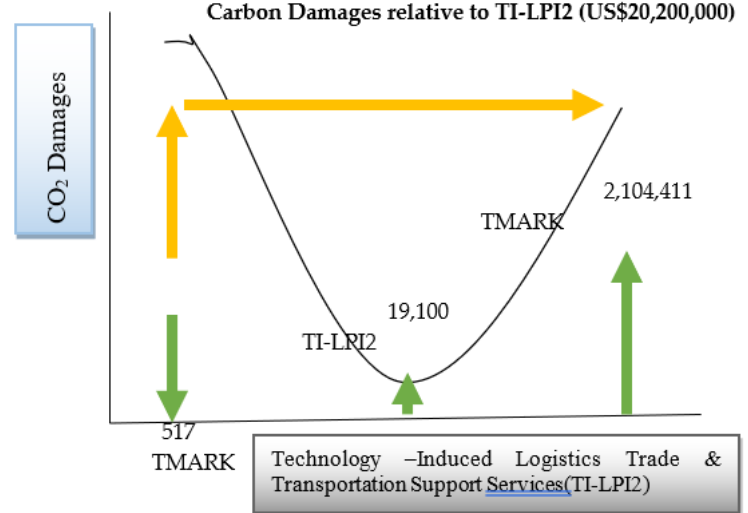
Figure 9. Moderation U-shaped Curve between Carbon Damages and Technology Induced Logistics Performance Indices (LPI2 × TMARK).